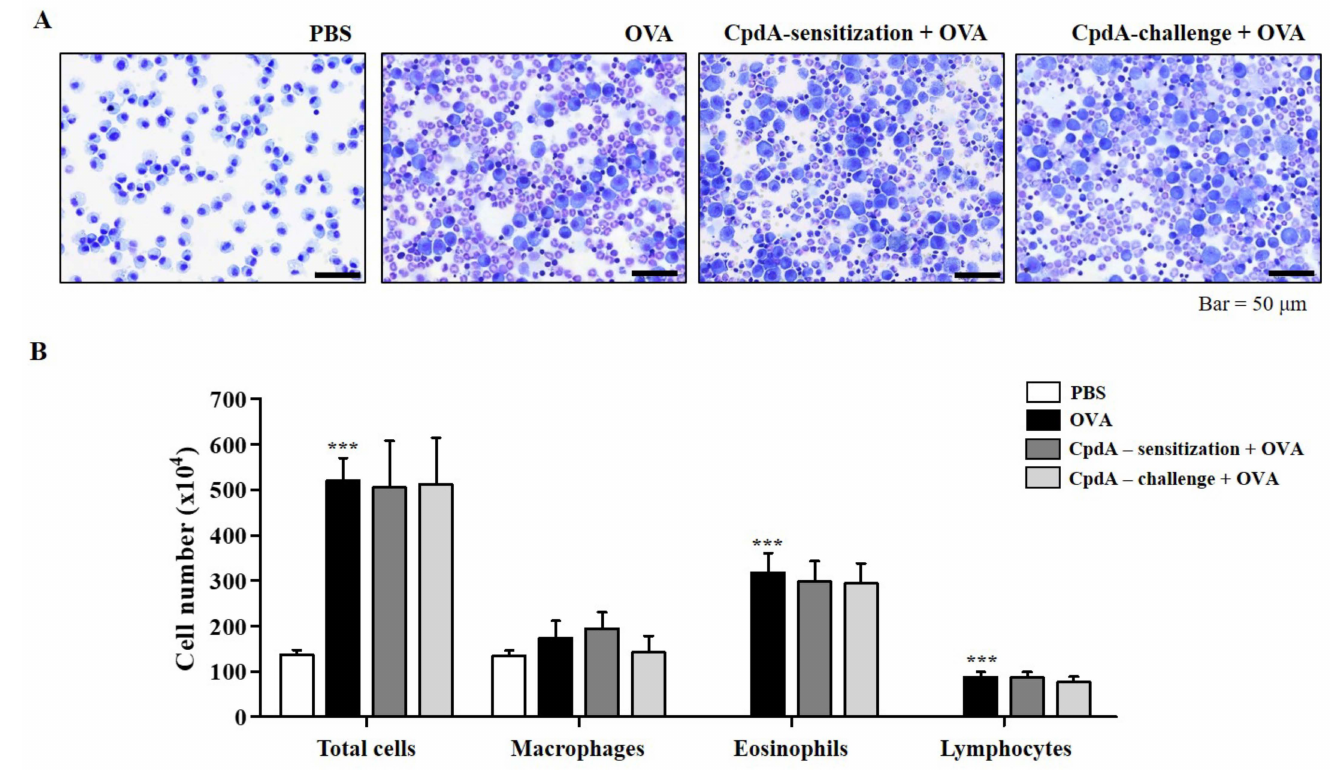
Figure 6. Compound A does not suppress OVA-induced immune cell accumulation in BALF of FFA4-KO mice. ( A ) Mice were sensitized and challenged, and compound A was administrated as described in FFA4-WT mice. BALF cells were stained using May-Grünwald stain and counted. ( B ) Total cell counts, eosinophils, macrophages, and lymphocytes in BALF. The results are presented as the mean ± SEM of cell count values ( n = 5). *** p < 0.001 vs. the PBS-treated